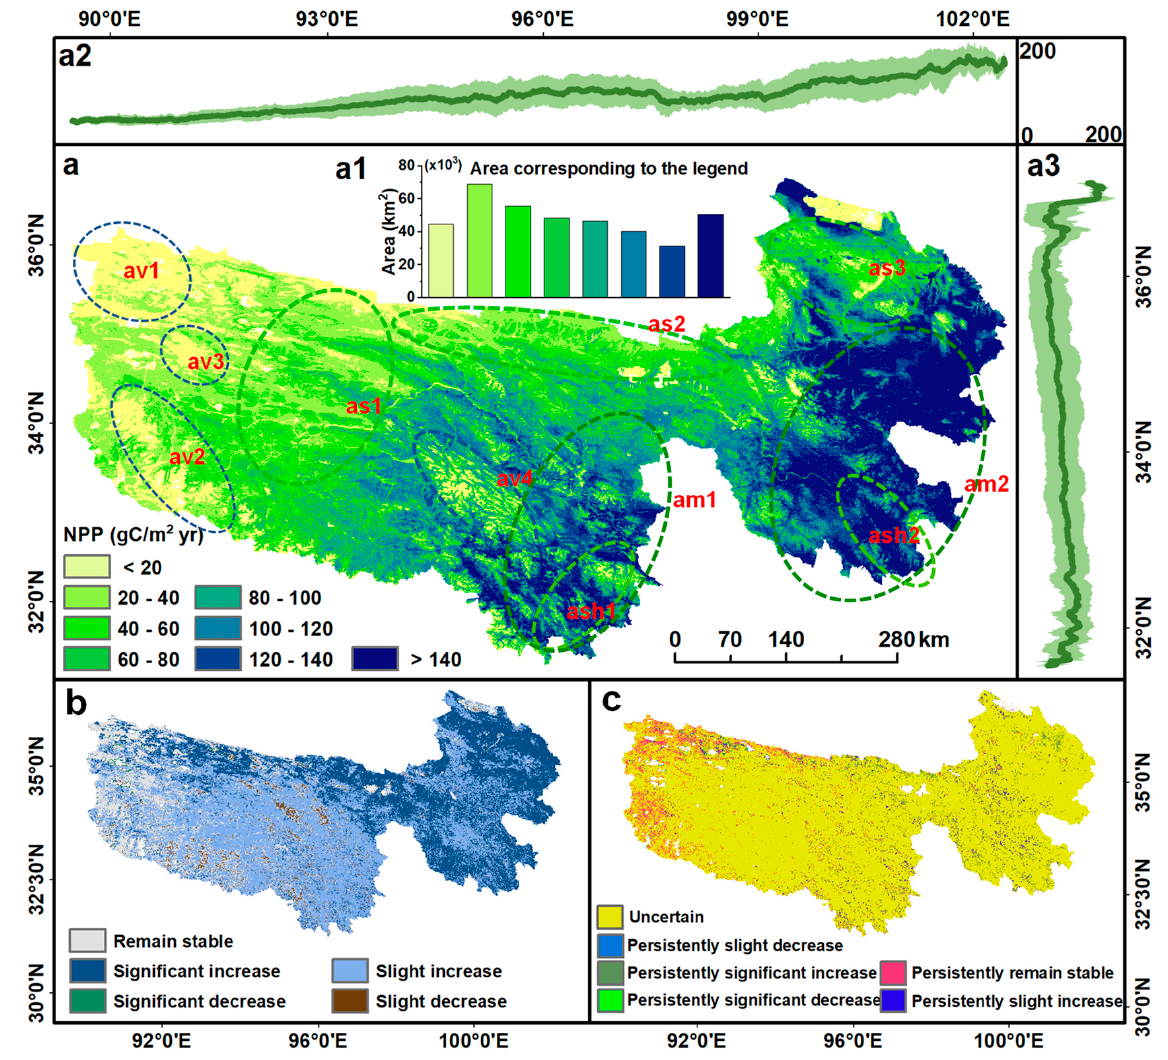
Figure 4. Distribution of the net primary productivity (NPP) and its changing trend in the Three-River Headwaters region, including ( a ) the average NPP from 2001 to 2020, av: alpine vegetation, as: alpine steppe, am: alpine meadow, ash: alpine shrub land; ( a1 ) the area percentage corresponding to the eight classes in the ( a ); ( a2 ) the average NPP and its one standard deviation (SD) along the longitude; ( a3 ) the average NPP and its SD along the latitude; ( b ) the changing trend of NPP from 2001 to 2020; ( c ) the changing characteristics of the NPP from 2001 to 2020.